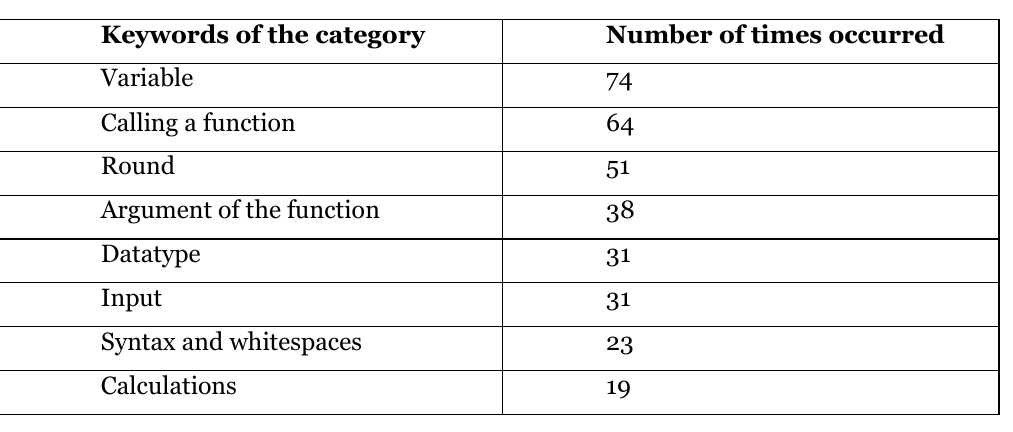
Categories of Occurring Problems for Task